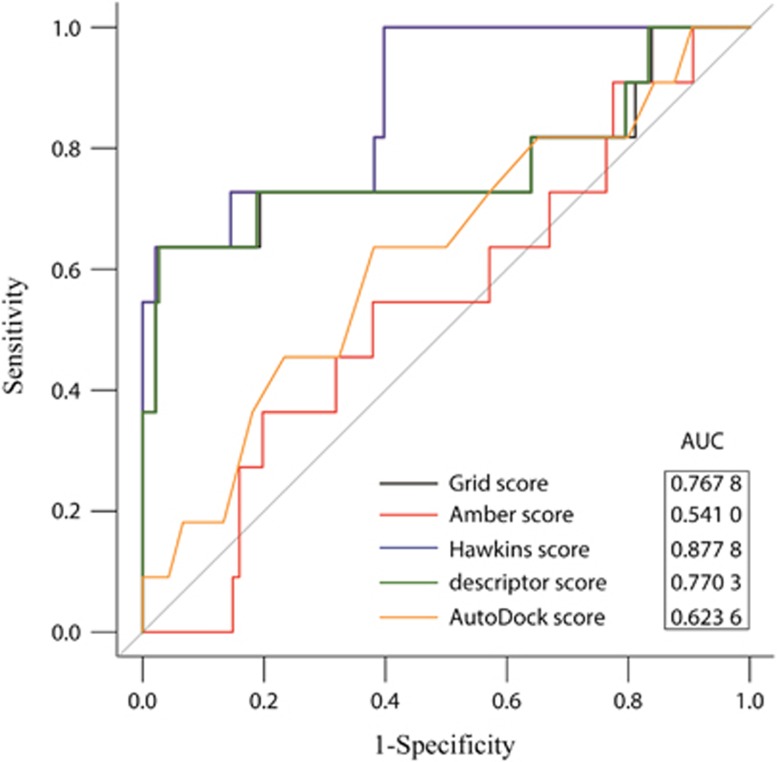
ROC curves of docking test with 11 inhibitors and 210 decoys. ROC, receiver operating characteristic curve.